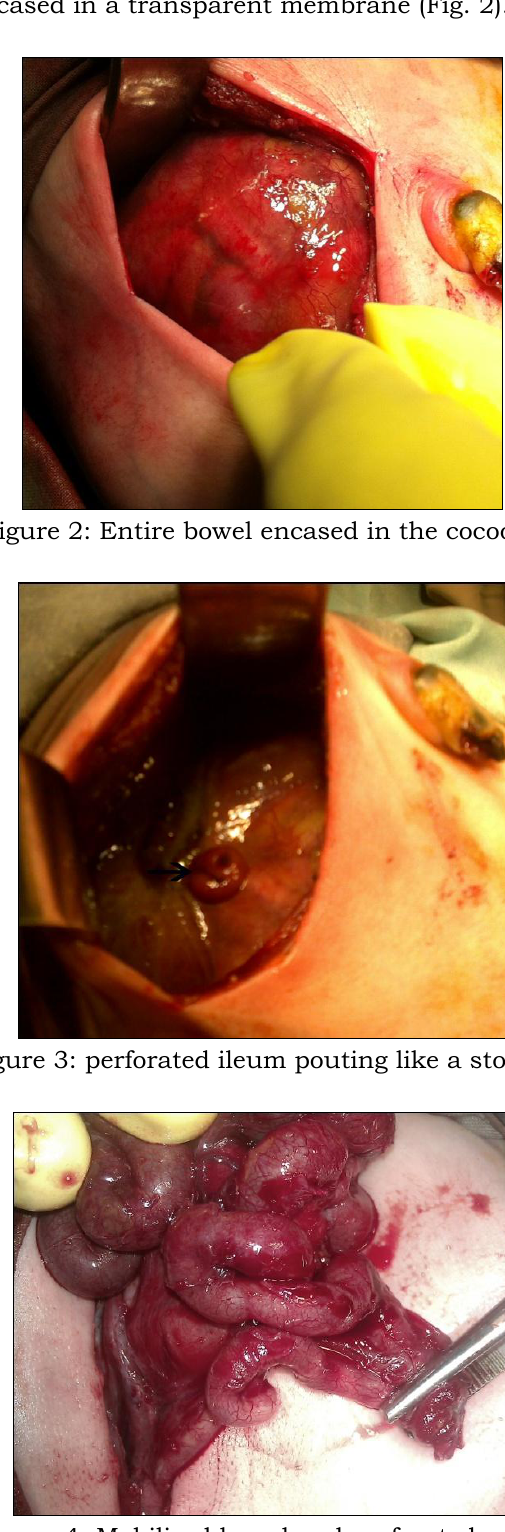
Figure 4: Mobilized bowel and perforated ends in